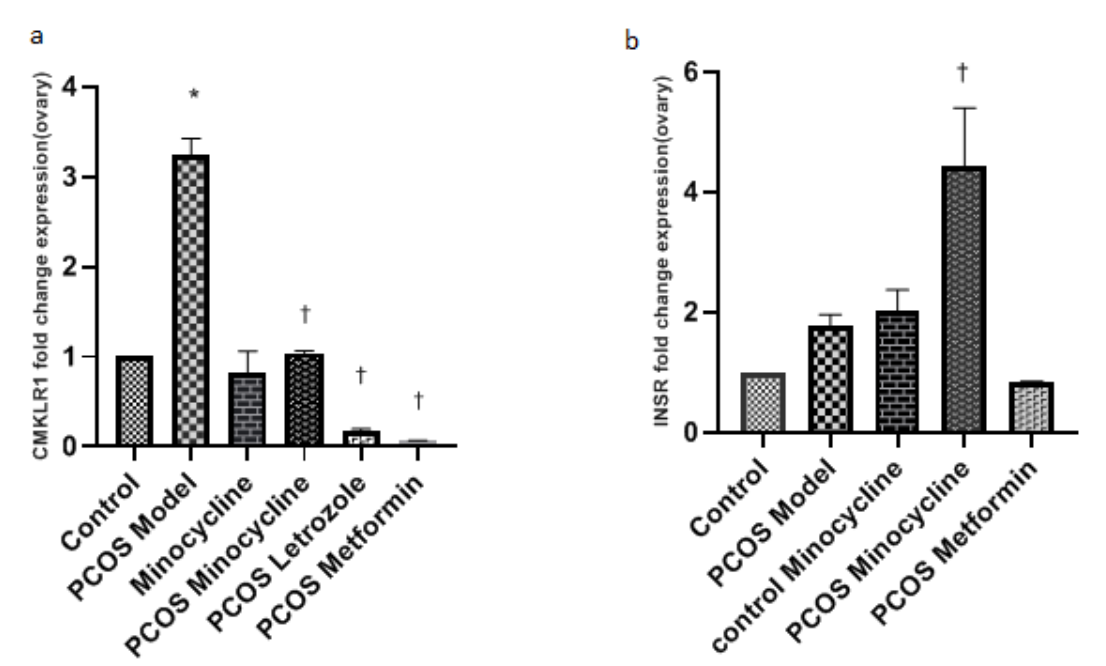
Figure 4: Comparison of CMKLR1 and INSR gene expression in different experimental groups. a ) The expression of the CMKLR1 gene in the PCOS increased significantly compared to the control (*: P<0.0001) whereas, its expression in the PCOS treated by minocycline and letrozole showed a significant decrease compared to the PCOS model group (†:P<0.0001). b ) INSR gene expression sig- nificantly increased in the PCOS treated with minocycline vs. PCOS model (†: P<0.001). The results were measured by One-Way ANOVA and presented mean ±